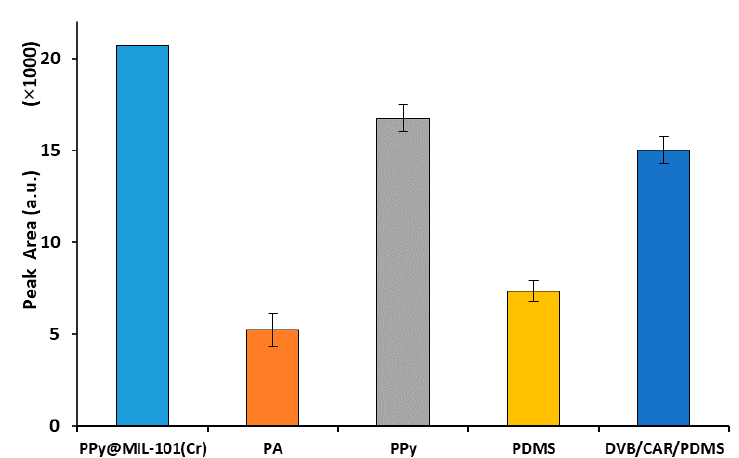
Figure 6. Comparison of the PPy@MIL-101(Cr)-coated SPME fiber with commercial fibers and PPy handmade fiber for sampling of MTBE in solid samples.